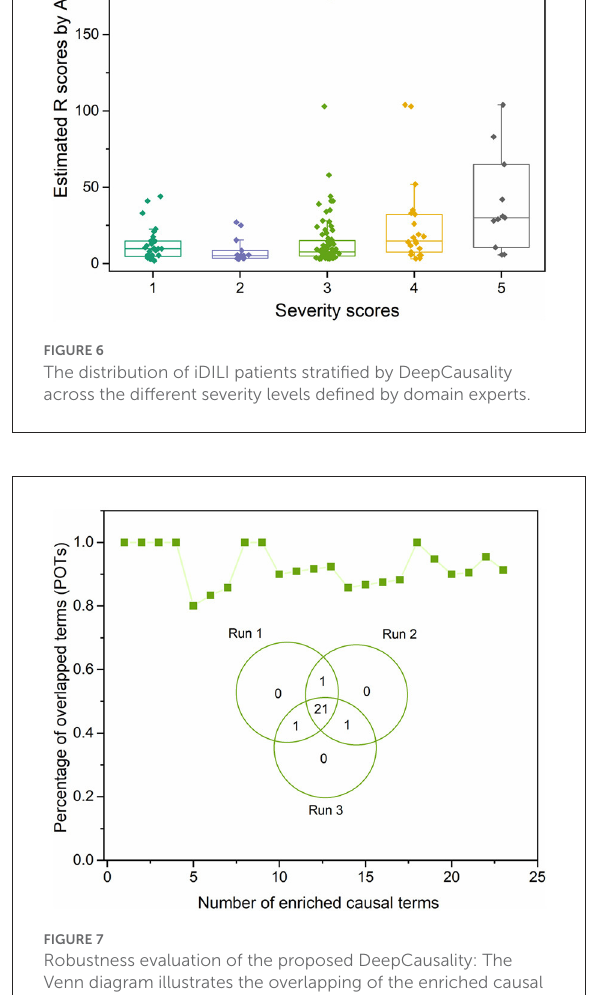
available, this step could also be substituted with domain-specific ontology and knowledge